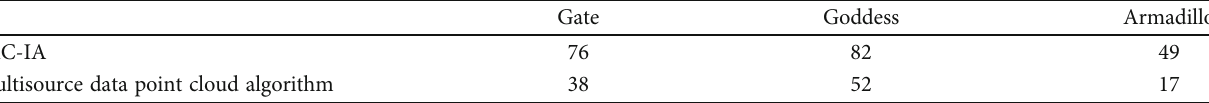
Table 2: Comparison of registration time between SAC-IA algorithm and multisource data point cloud